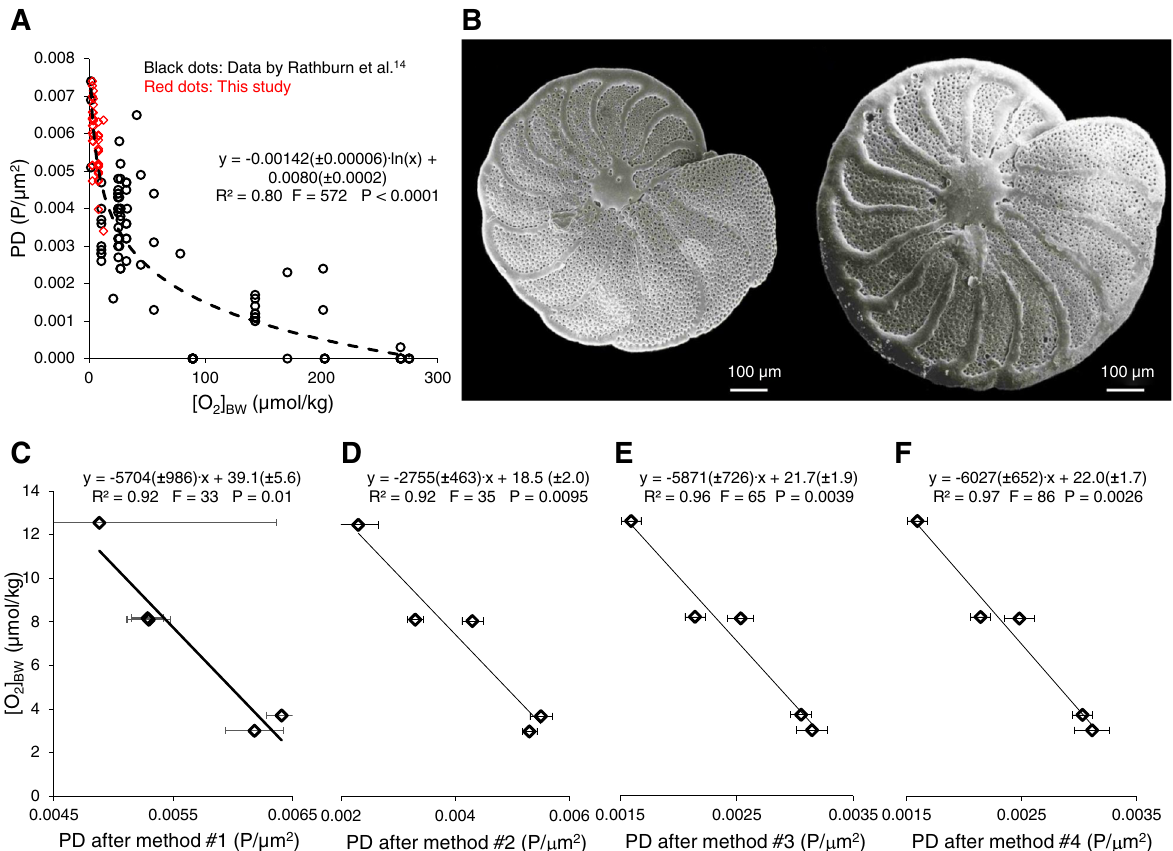
Fig. 4 Comparison of results and calibrations for different pore density (PD) determination methods. A Comparison of epifaunal PD vs. bottom water O 2 concentrations ([O 2 ] BW ) correlation between our study ( Planulina limbata ; red dots) and Rathburn et al. 17 (Mixed species; black dots). PDs of each individual foraminiferal specimen are plotted. All PDs in this plot were determined after method #1. The dashed line is a logarithmic regression through all datapoints (Equation and statistics are shown in fi gure). B Scanning electron micrographs of two epifaunal P. limbata specimens (umbilical side) with different porosity features. Left specimen (higher porosity) is from M77/1-487/MUC-39 ([O 2 ] BW = 3.70 µ mol/kg); Right specimen (Lower porosity) is from M77/1-565/MUC-60 ([O 2 ] BW = 8.17 µ mol/kg). C – F Comparison of the four methods that have been tested to determine the correlation between [O 2 ] BW and the mean the PD of P. limbata in each sample. For a detailed description of these methods see text. C Method #1; D Method #2; E Method #3; F Method #4. Solid lines are linear regressions (Equation and statistics are shown in fi gure). Error bars are the standard error of the mean (1